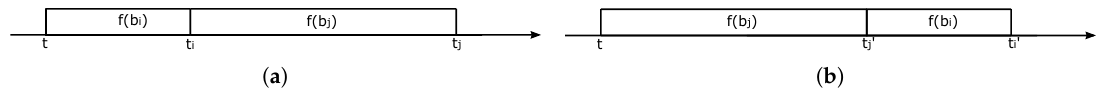
Figure 6. Different transmission order. ( a ) transmit b i first; ( b ) transmit b j